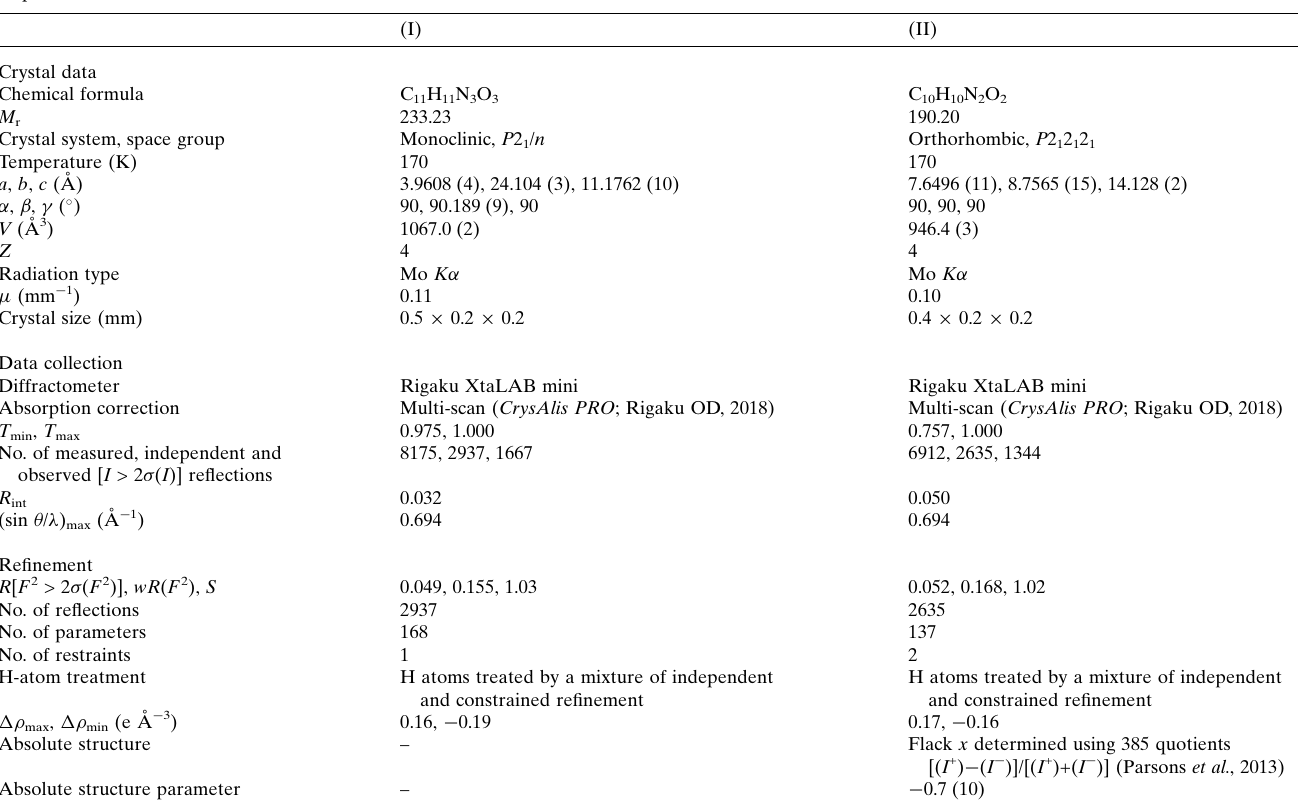
Table 3 Experimental details.